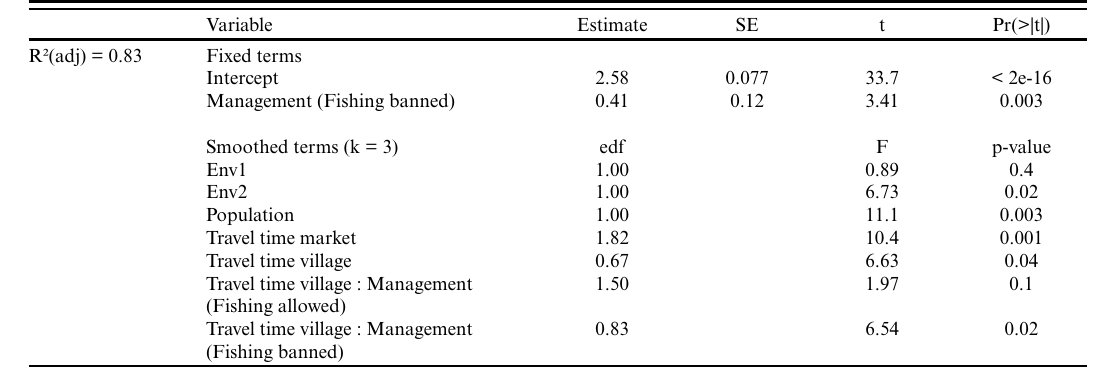
Table 3 . Significance table of all covariates included in the best-fit model of fish biomass (R² adj = 0.83). The two first components (Env1 and Env2) of the principal component analysis (PCA) performed with habitat and environmental variables, human population size, travel time from the nearest market, and travel time from community in interaction with management (fishing permitted vs fishing prohibited) provided the best-fit model. Estimates and standard errors (SE) of estimates of fixed terms while estimated degree of freedom (edf) of smooth terms are provided with corresponding significance test.